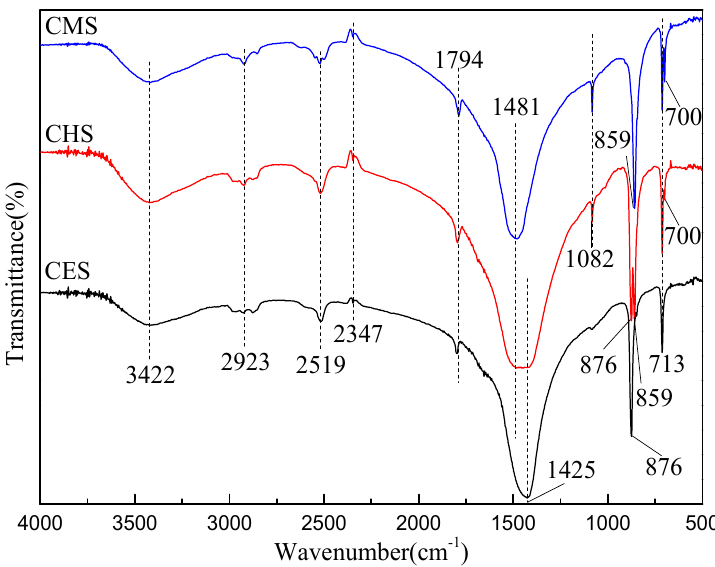
Figure 1. FTIR spectra of different shell bio-fillers. Table 2. FTIR assignments for the functional groups of different shell bio-fillers.